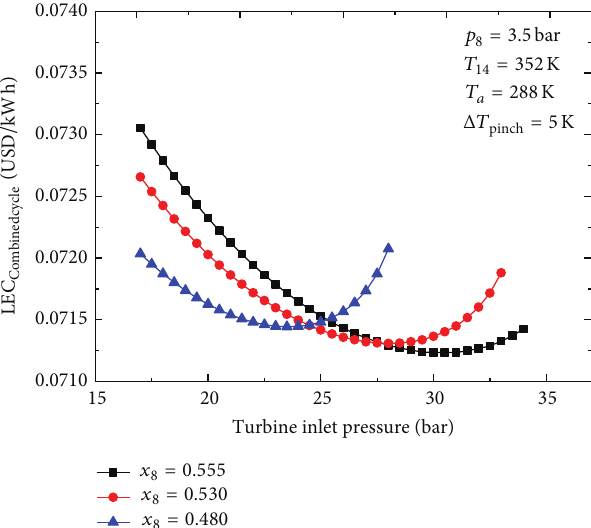
Figure 6: Variation of power output of combined cycle with turbine inlet pressure.